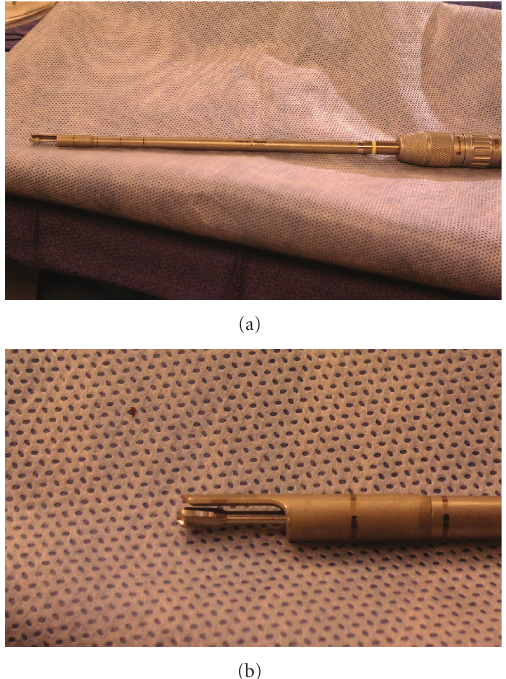
Figure 4: (a) Retractable, single-sided guard on the pneumatic drill bit protects the dura from inadvertent injury on one side while allowing visualization of the drill bit tip from the other side. (b) Zoomed-in view of the drill-bit that is a variant of the AM8 standard drill (Midas Rex,